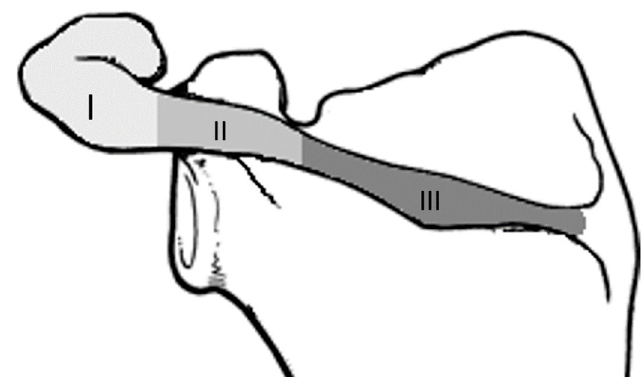
Figure 1. Illustration of the Levy classification of acromial fractures.